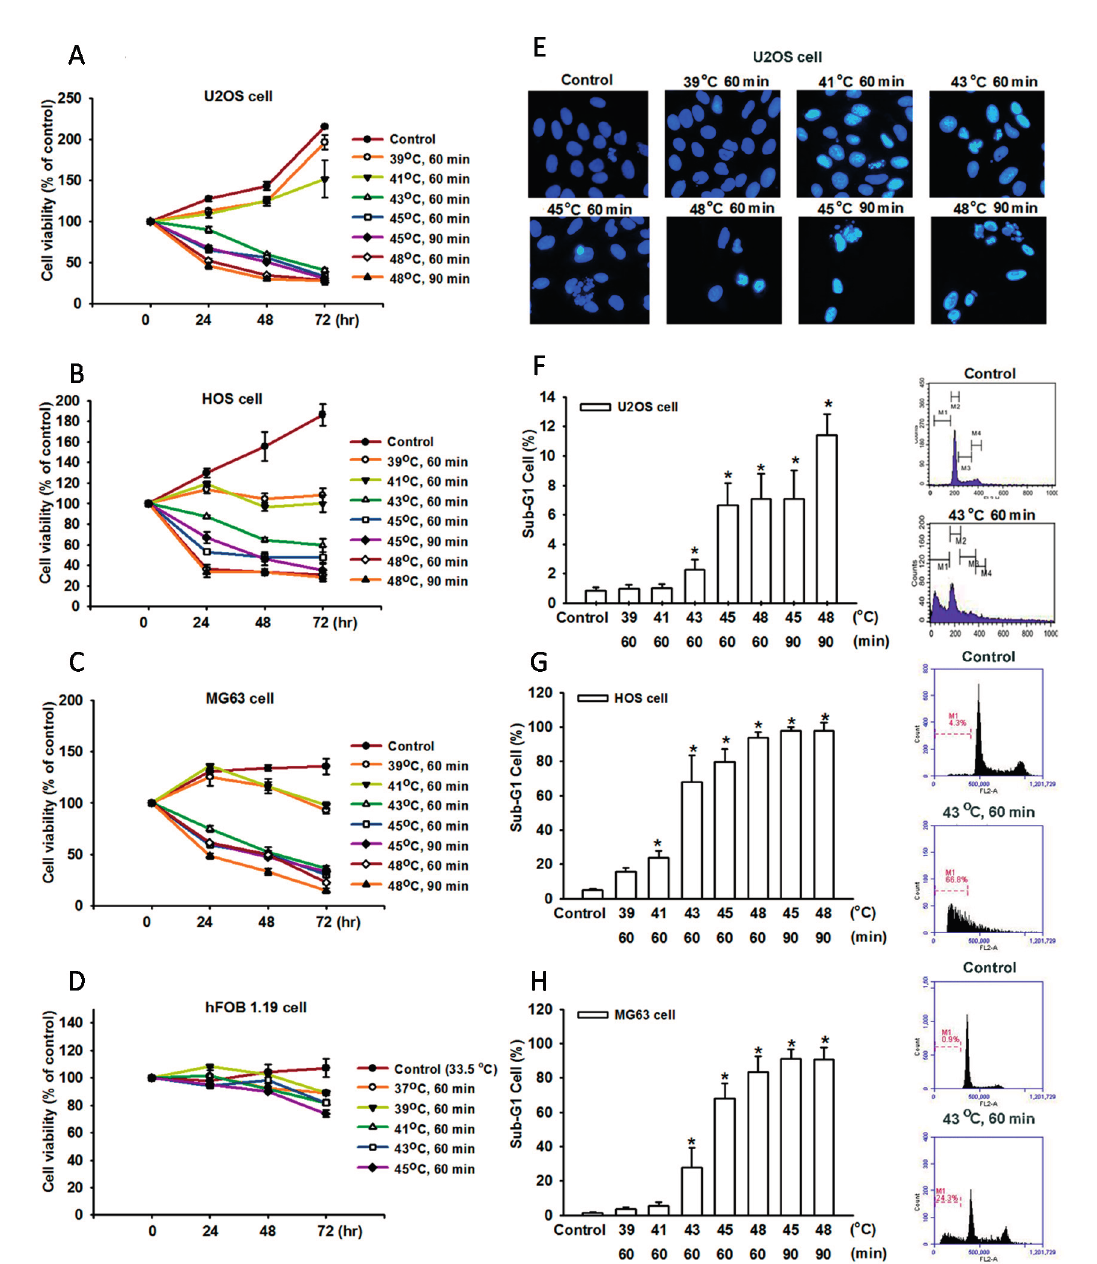
Figure 1. Hyperthermia-induced cell apoptosis in human OS cells. ( A – D ) Cells were incubated at various temperatures of hyperthermic conditions. After 24, 48, and 72 h, cell viability was examined by sulforhodamine B (SRB) assay; ( E ) U-2 OS cells were treated at various temperatures of hyperthermic conditions. After 24 h, DAPI stains was determined using immunostaining and were photographed using a fluorescence microscope; ( F – H ) of apoptotic cells was analyzed by conducting flow cytometric analysis on PI-stained cells. Cells were treated at various temperatures of hyperthermic conditions. After 24 h, the percentage. The results are expressed as the mean ± SEM of 4 independent experiments. * , p < 0.05, compared with the control